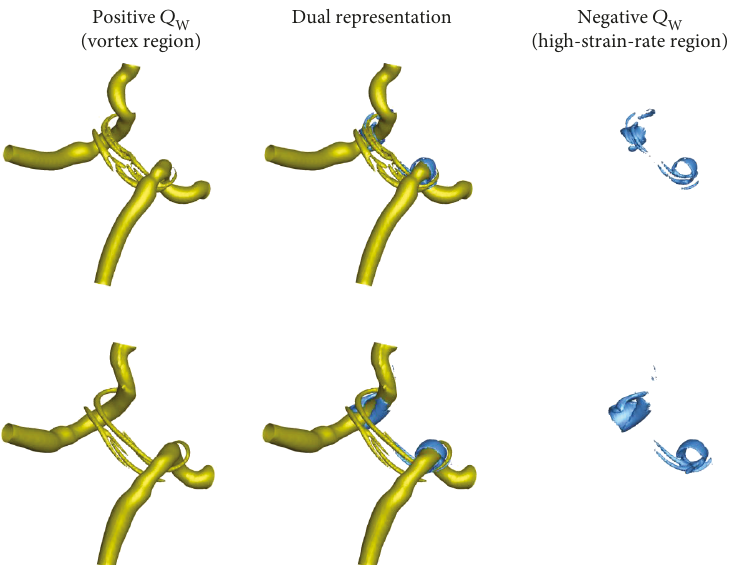
Figure 4: Dual isosurface representation of the interaction of Burgers vortices for Mach numbers 0.3 (top, isovalues +2 and − 400) and 0.8 (bottom, isovalues +2 and − 200) using Q W